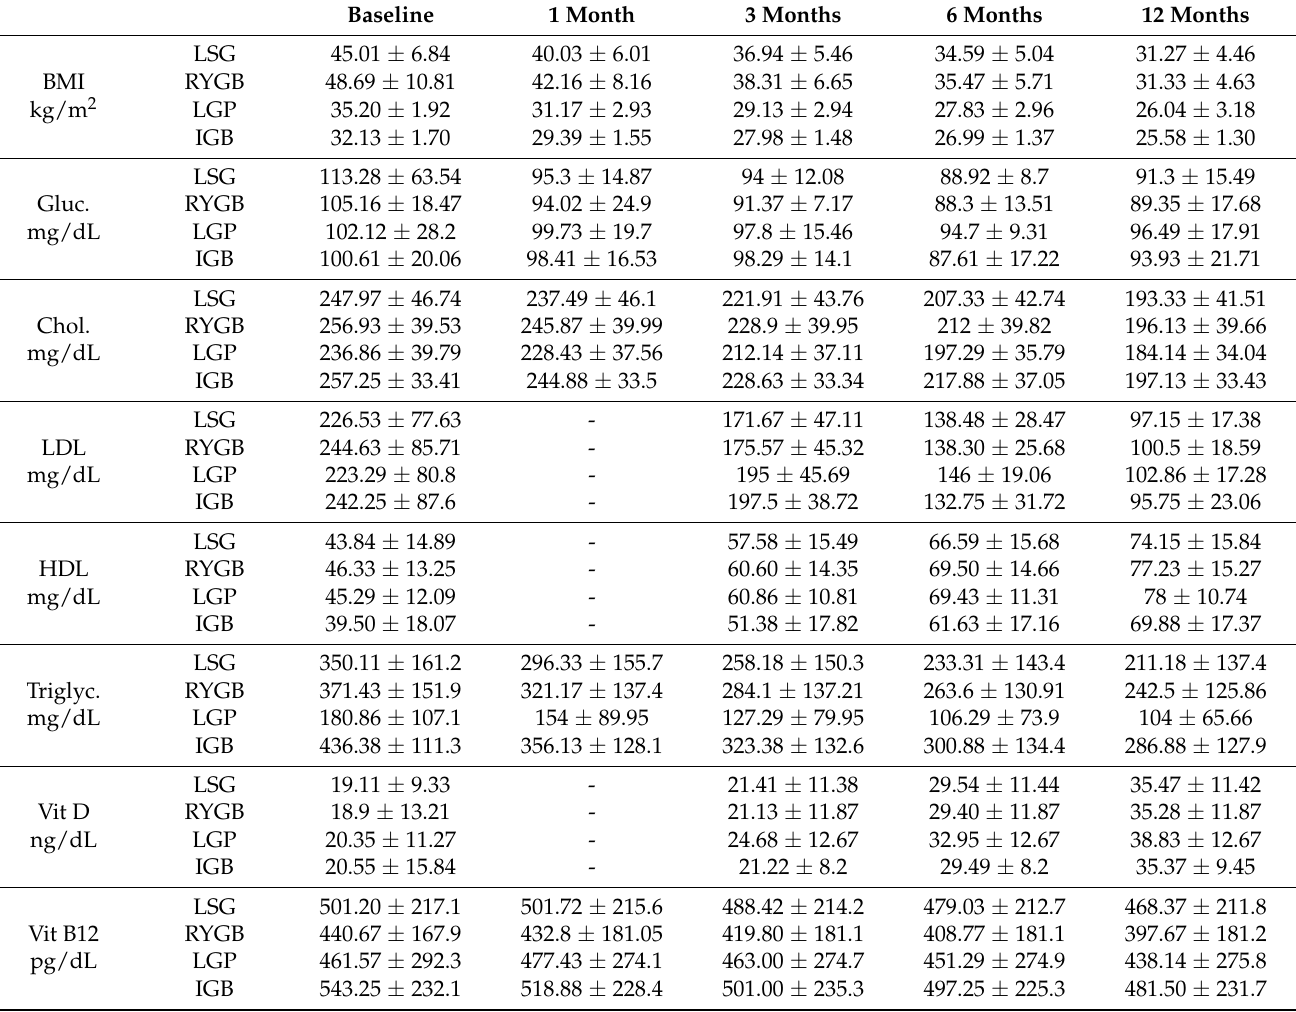
Table 1. Metabolic parameters variation during